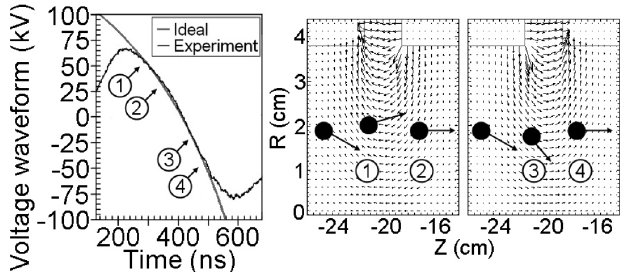
FIG. 23. (Color) Illustration of the radial defocusing effect of the acceleration gap. For dV (cid:2) t (cid:3) =dt < 0 , particles crossing the gap early in time [when V (cid:2) t (cid:3) > 0 , shown as 1 and 2] sample more at the entrance compared to the exit, whereas integrated (cid:8) E r particles crossing the gap late in time [when V (cid:2) t (cid:3) < 0 , shown as at the exit compared to the 3 and 4] sample more integrated (cid:8) E r entrance. In the center and right frames, electric field vectors are plotted and the black arrows indicating particle velocity vectors are